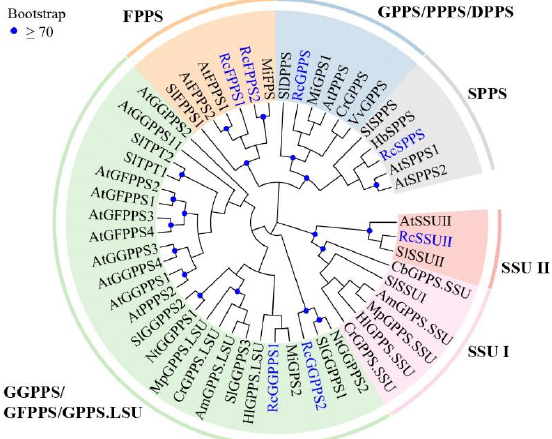
Figure 2. A maximum likelihood phylogenetic tree was constructed by aligning the amino acid sequences of seven RcTPTs and other characterized trans -prenyltransferases in eudicots. RcTPTs are highlighted in blue. The sequences used in this analysis are listed in Table S1. Table 1. Members of full-length RcTPT genes and their sequence characteristics.